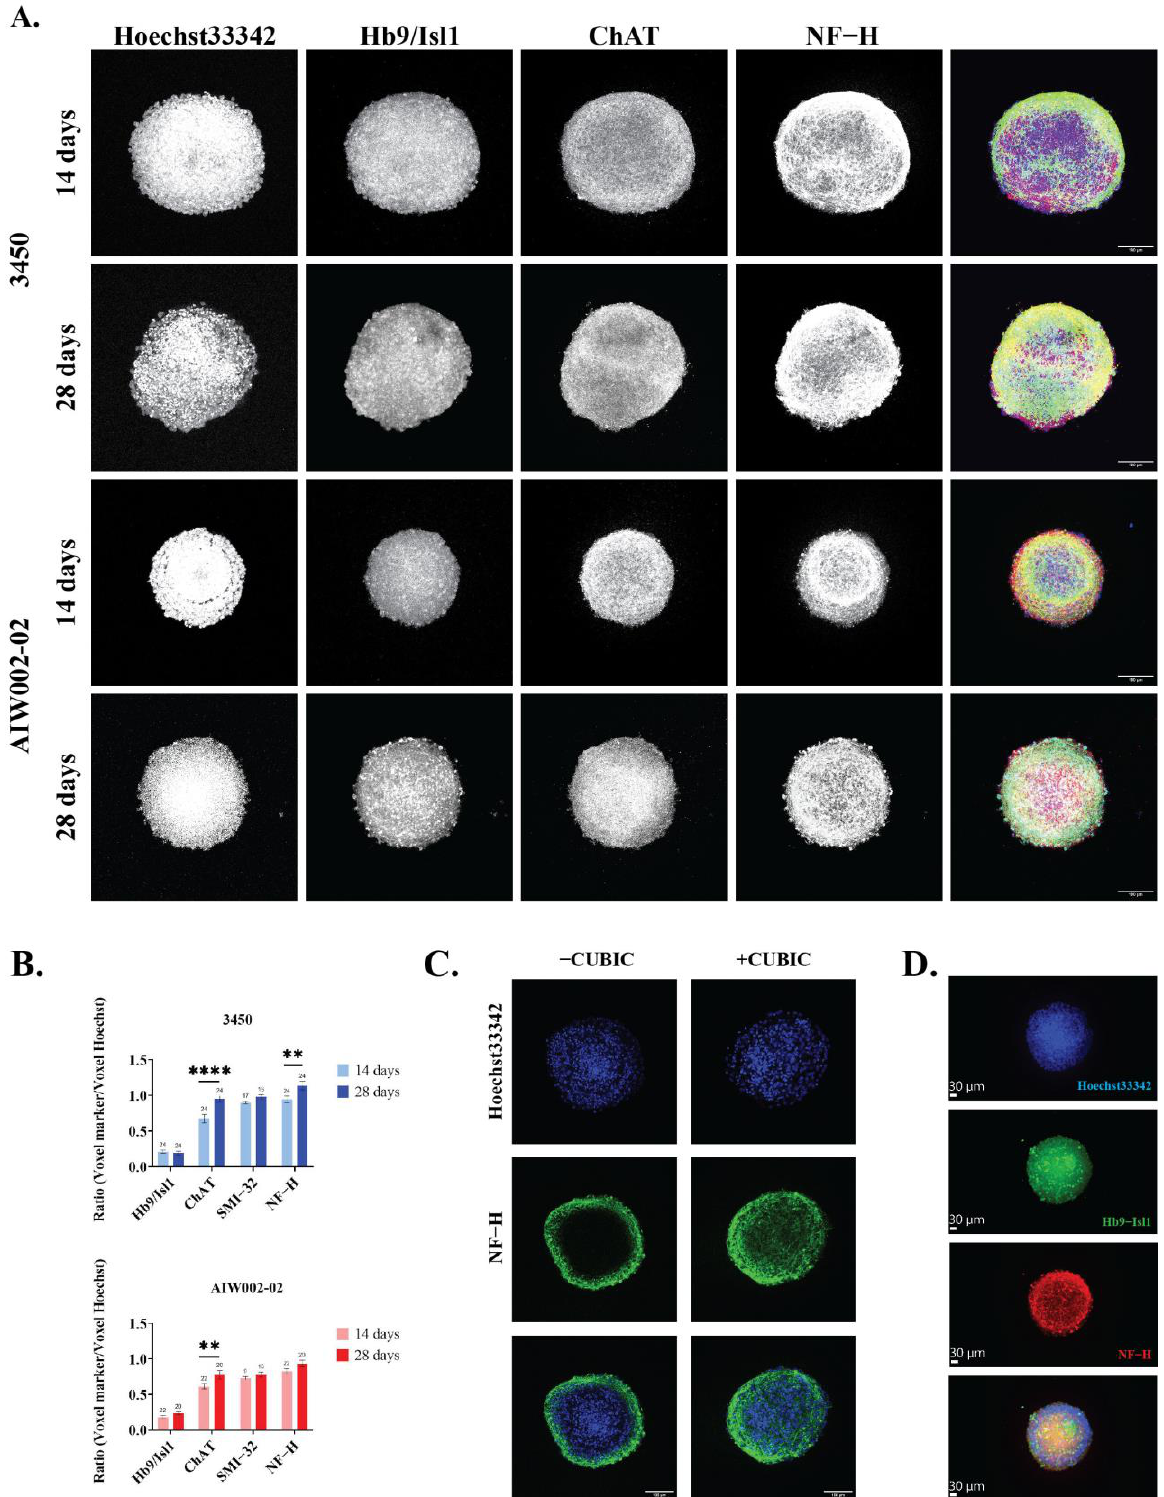
Figure 4. Image profiling of iPSC-derived MN spheroids. ( A ) Characterization of MN spheroids by immunostaining showed that MN spheroids generated from the 3450 and AIW002-02 iPSC lines express the specific MN markers Hb9, Isl1, CHAT, and SMI − 32 (not shown), as well as the neuronal marker NF − H. Merge shows overlay of Hb9/Isl1 (blue), CHAT (red), and NF − H (green). ( B ) The presence of each MN marker was quantified using an in-house MATLAB pipeline. Graph bars show the mean ± SEM; for each cell line, each batch of three batches of iPSC-derived MNPCs generated through independent differentiation processes were used to generate two MN spheroid batches. A